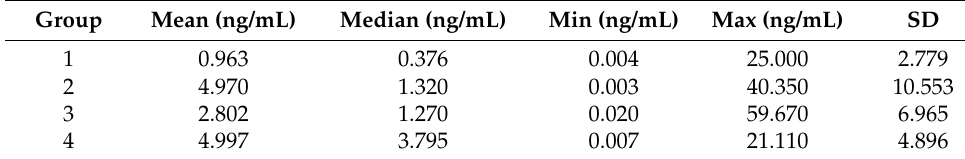
Table 1. Mean values for PSA level in the analyzed groups.